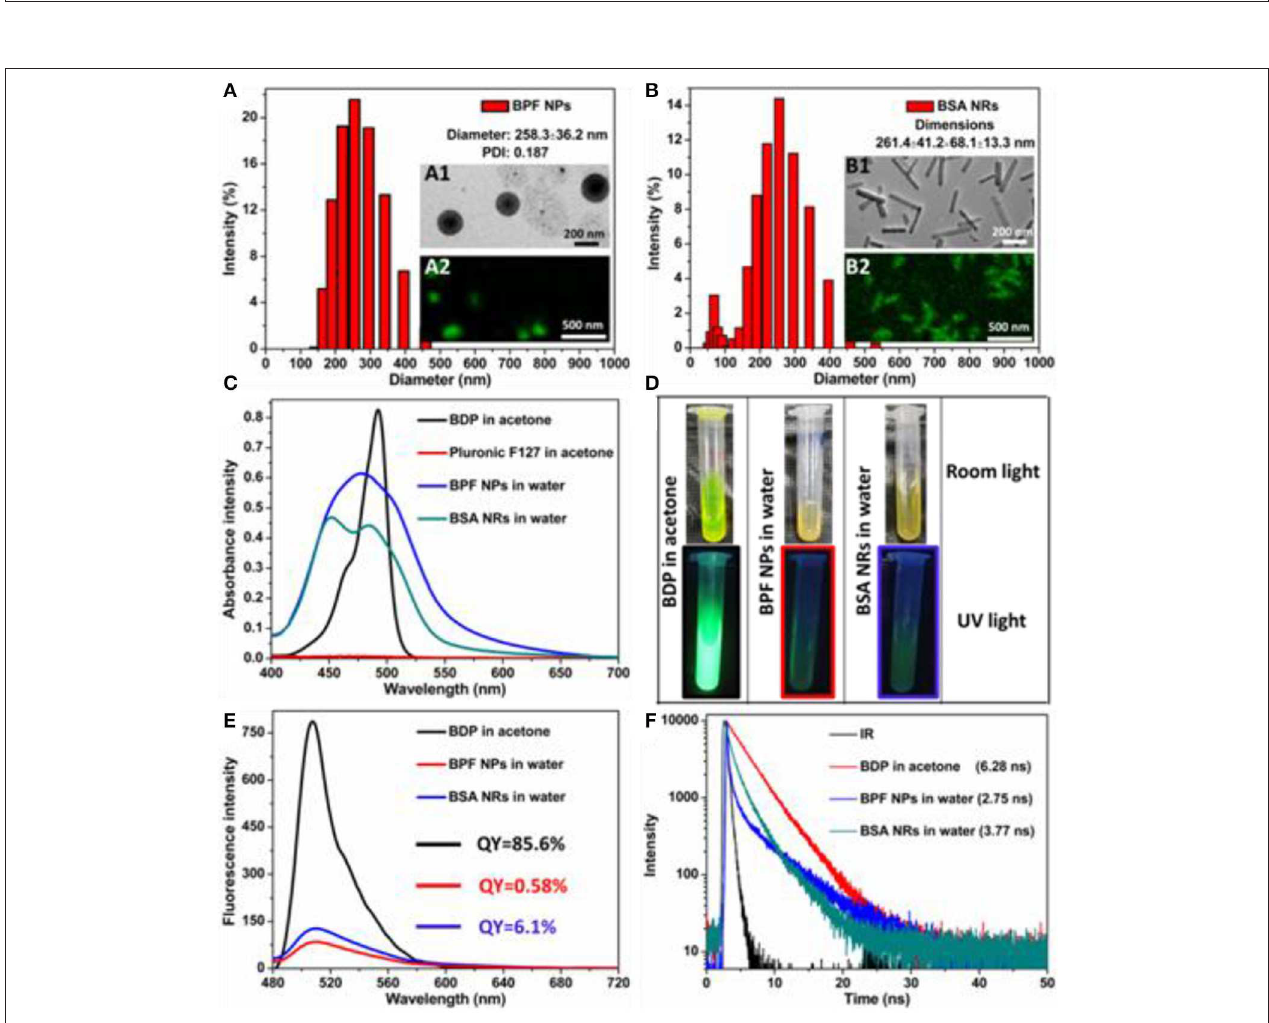
Frontiers in Chemistry |